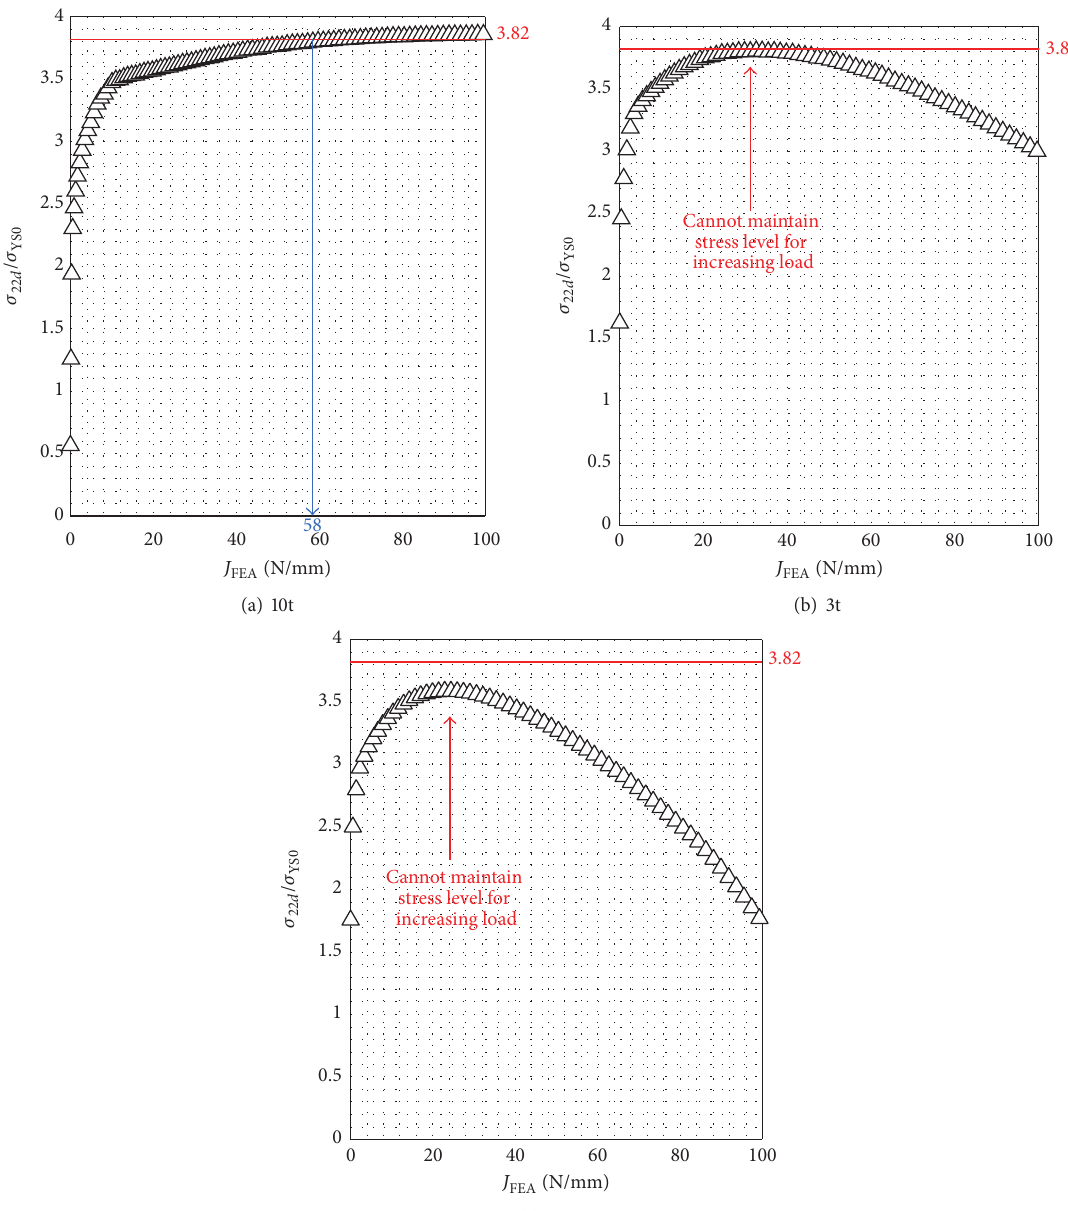
Figure 9: The relationships between 𝜎 22𝑑 and 𝐽 FEA for the 10t, 3t, and 2t SE(B) specimens (S55C, 20 ∘ C): 𝜎 22𝑑 for 10t specimen reached the critical stress 𝜎 22𝑐 ; the stress level was maintained for increasing 𝐽 FEA , indicating occurrence of cleavage fracture within negligible stable crack fracture). In contrast, 𝜎 22𝑑 for 3t and 2t specimens showed a maximum for increasing load, indicating low possibility of 𝐾 𝐽 extension ( 𝐾 𝐽 𝑐